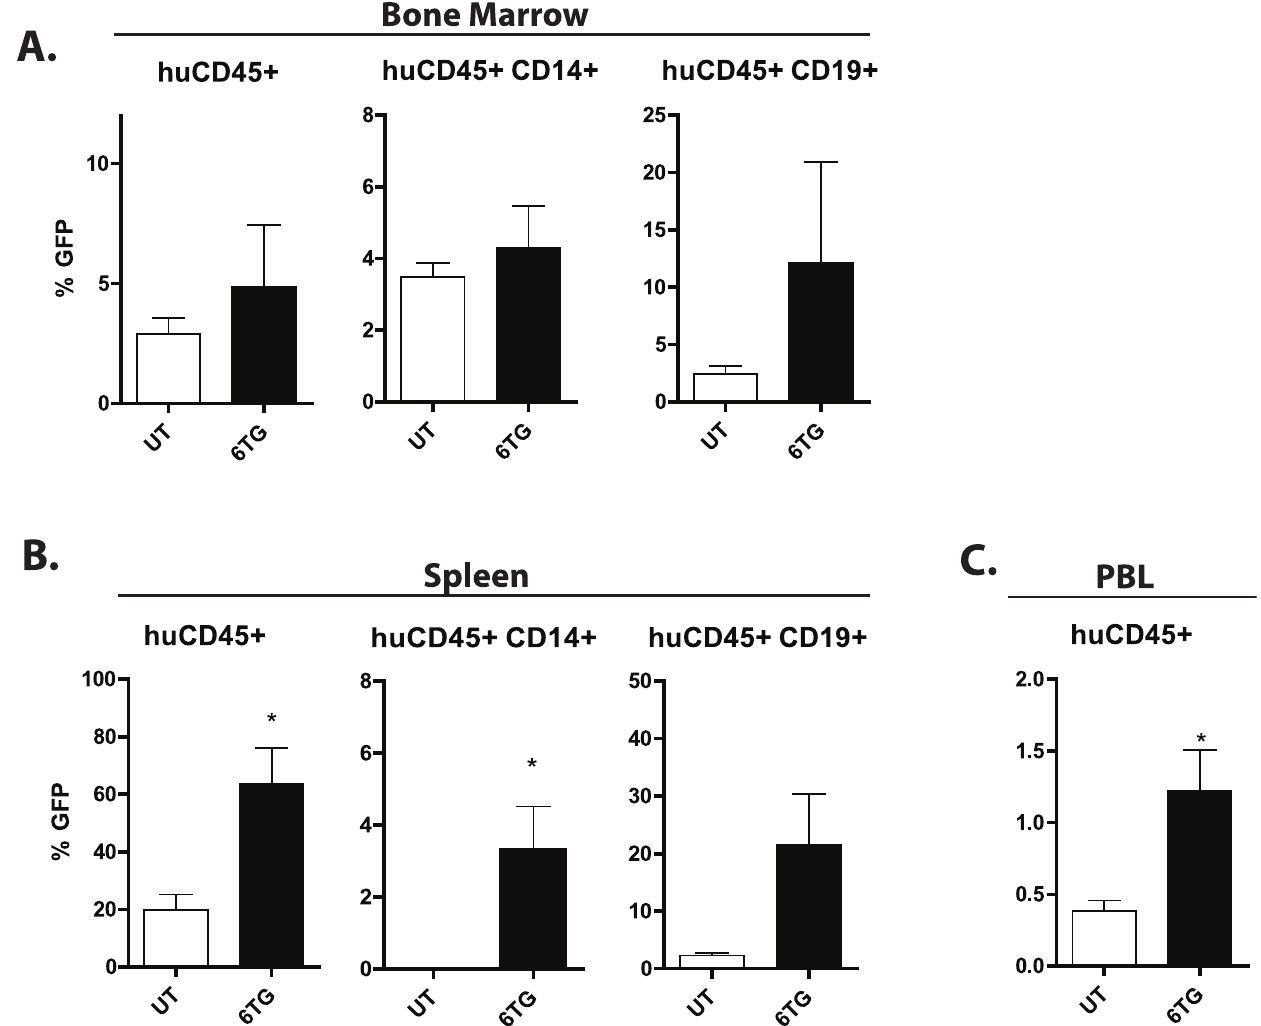
Figure 4. Knockdown of HPRT allows for maintenance of transduced HPC in NOD/SCID recipients. Human CD34 + umbilical cord blood cells were transduced with GFP expressing vectors with shRNA directed against HPRT, mixed with untransduced cells, and transplanted into sub- lethally irradiated NOD/SCID recipients. Mice were then treated with 6TG 2 mg/kg/d in the drinking water (n=3) or left untreated (n=4). After 6 weeks, bone marrow (A), spleen (B), and peripheral blood (C) were analyzed by flow cytometry for cell surface markers for total human leukocytes, B- lymphocyte and myeloid subpopulations, and GFP. A. Human HPC with reduced HPRT in the BM are maintained with or without treatment with 6TG. The percentages of GFP + human leukocytes (huCD45 + ), and B-lymphocyte (huCD45 + CD19 + ) and myeloid (huCD45 + CD14 + ) sub-populations are depicted. While there is a trend for larger percentages of transduced cells in the 6TG treated recipients, the difference is not statistically significant. B. Human hematopoietic cells with reduced HPRT are selected with 6TG in the spleen. The percentages of GFP + human leukocytes (huCD45 + ), and B- lymphocyte (huCD45 + CD19 + ) and myeloid (huCD45 + CD14 + ) sub-populations are depicted. The percentage of transduced human CD45 + and CD14 + cells was significantly greater in the 6TG treated recipients. C. Human hematopoietic cells with reduced HPRT are selected with 6TG in the peripheral blood. The percentages of GFP + human leukocytes (huCD45 + ) are depicted. While the percentages of circulating human cells was low, there were significantly more transduced cells in 6TG treated recipients, as compared to